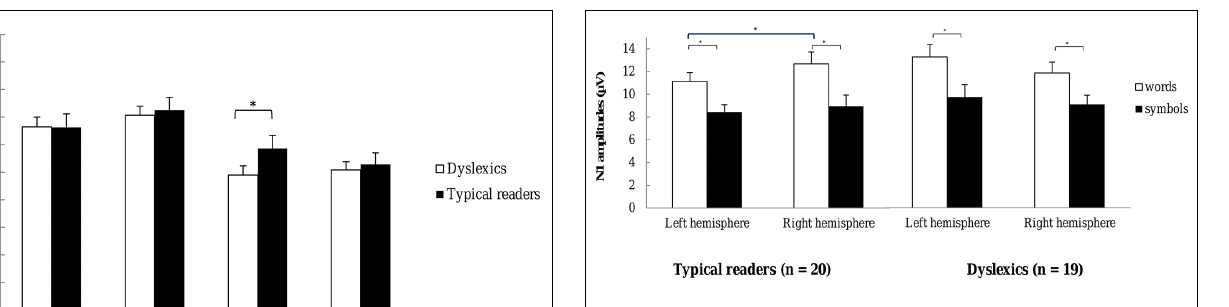
FIGURE 5 | N1 amplitudes for words and symbols recorded over the left and right hemisphere sites. Open bars refer to N1 amplitudes for word strings and filled bars to the N1 amplitudes for symbol strings.The left hemisphere N1 amplitudes are averaged across the sitesTP7, P9, P7, P5, PO7, PO3, and O1, and the right hemisphere amplitudes across homologue pairs. Plots represent N1 amplitudes in typical readers (left) and in dyslexics (right). * p <